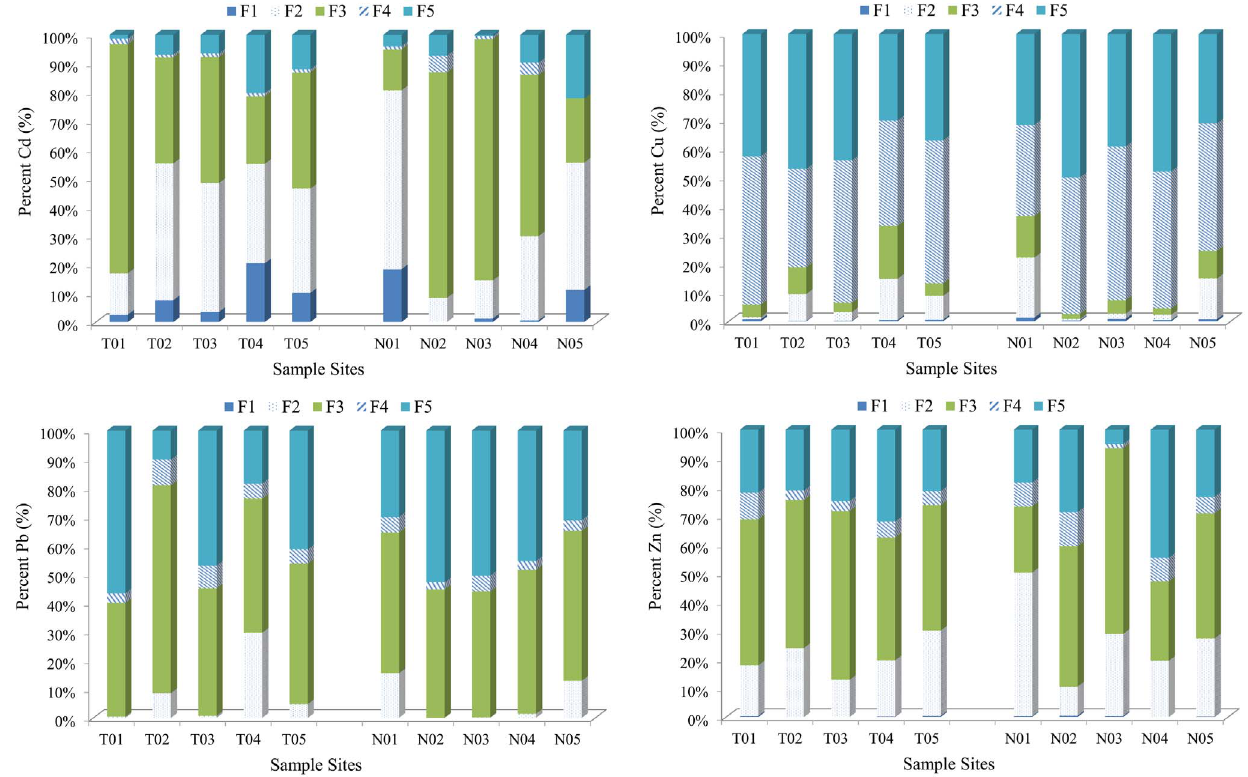
Figure 3. Fractionation of Cd, Cu, Pb and Zn in sediment and soil samples from Xiawangang River. F1: exchangeable, F2: bound to carbonates, F3: bound to Fe/Mn oxides, F4: bound to organic matter, F5: